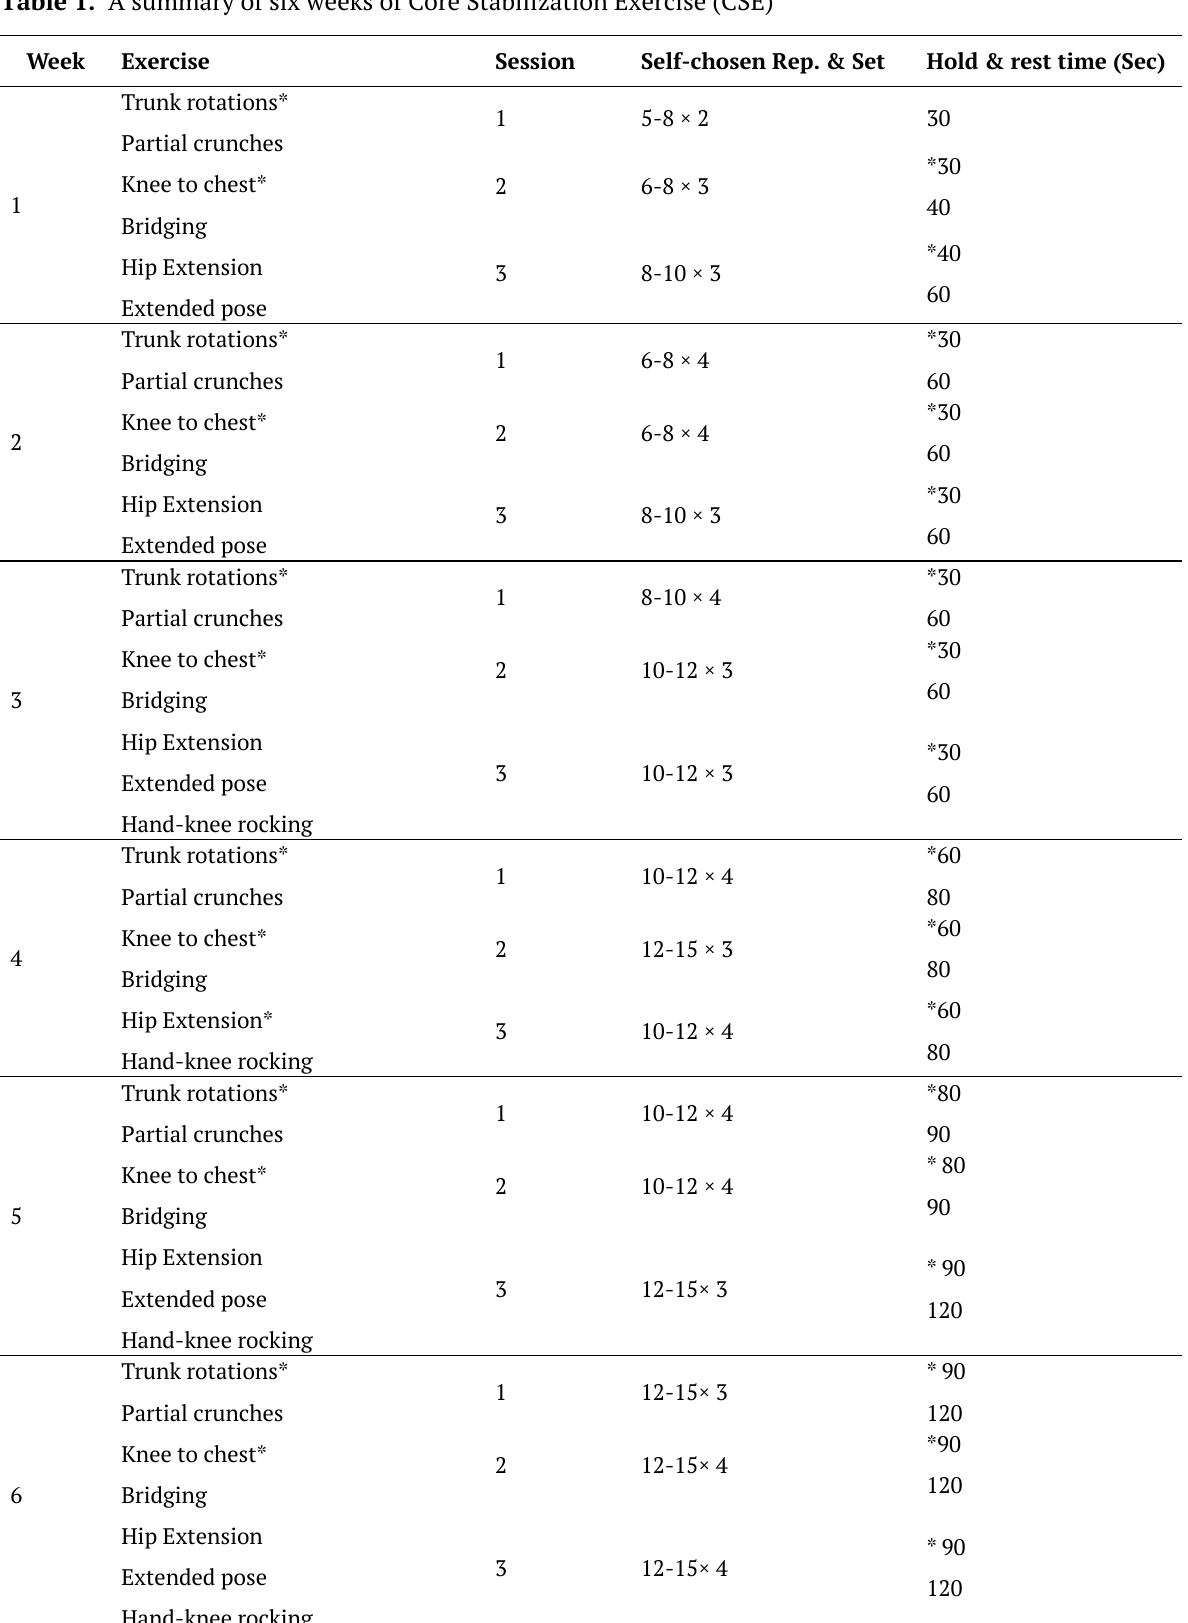
Table 1. A summary of six weeks of Core Stabilization Exercise